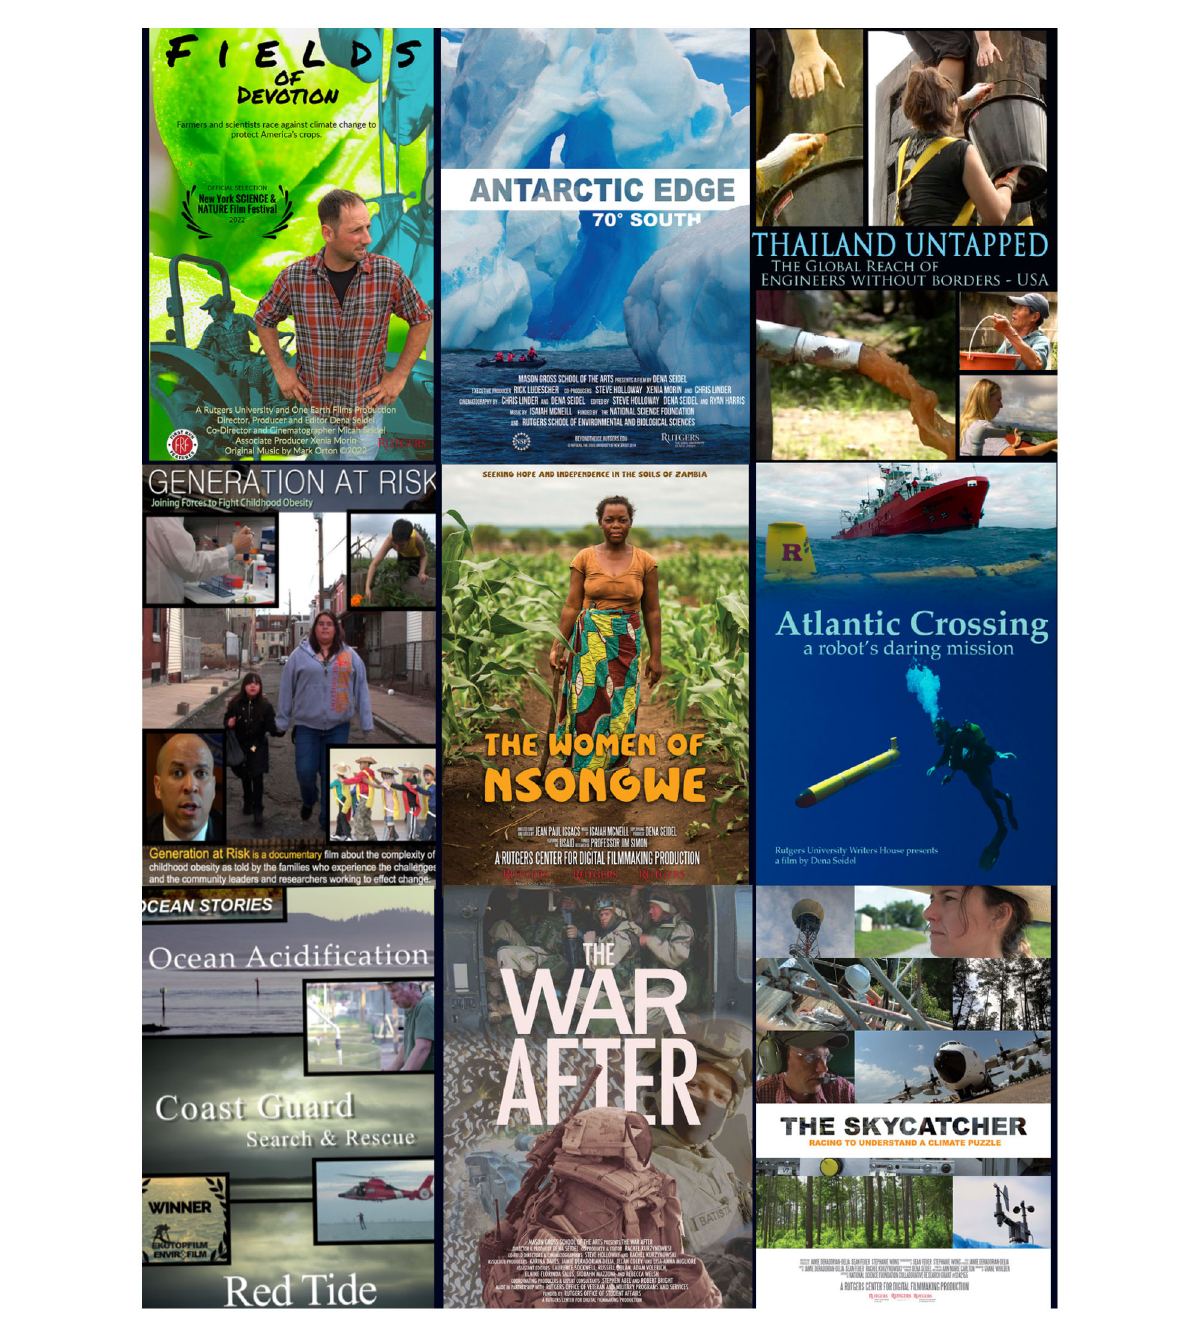
FIGURE6 Posters from original science-in-action video stories that reached public audiences through a variety of platforms including Netflix, Kanopy, iTunes, Public Broadcasting Service (PBS), PIVOT Channel and national funding agency